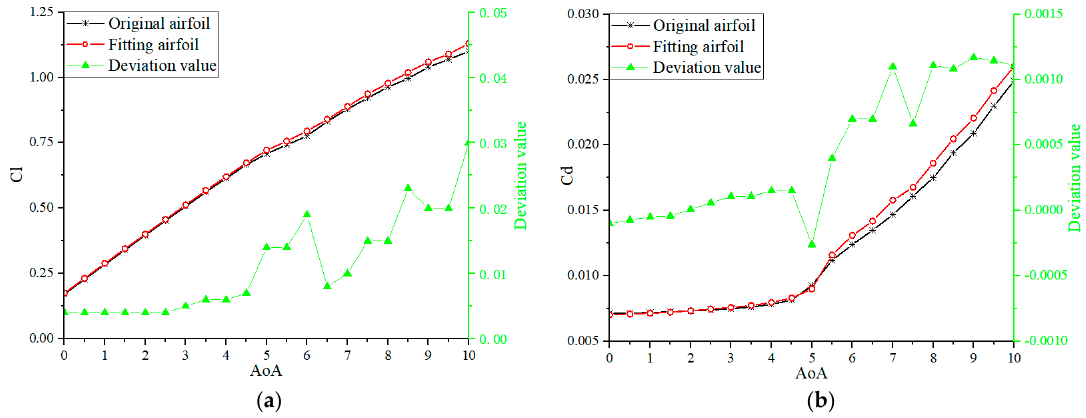
Figure 10. Lift and drag analysis. ( a ) Cl-AoA; ( b ) Cd-AoA.